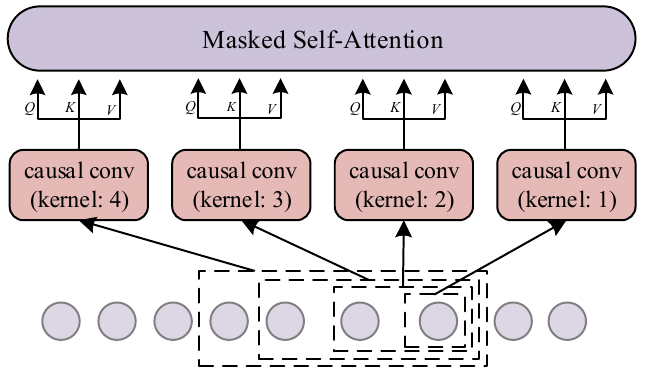
Figure 2. The Local-Range Convolutional Attention. Q , K , V represent query matrix, key matrix, value matrix, respectively.